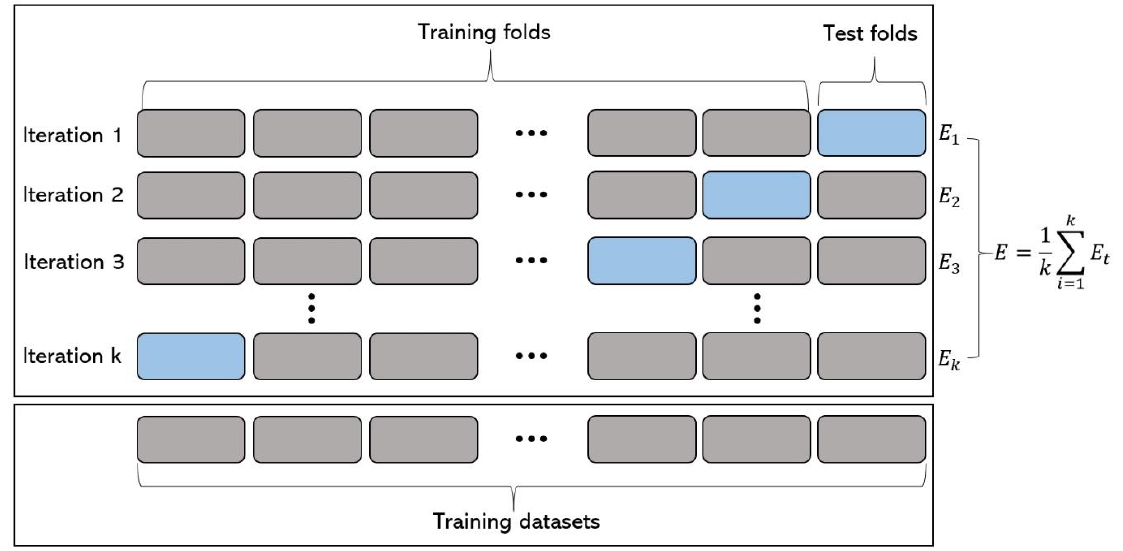
Figure 9. Data partitioning scheme with K-fold validation.